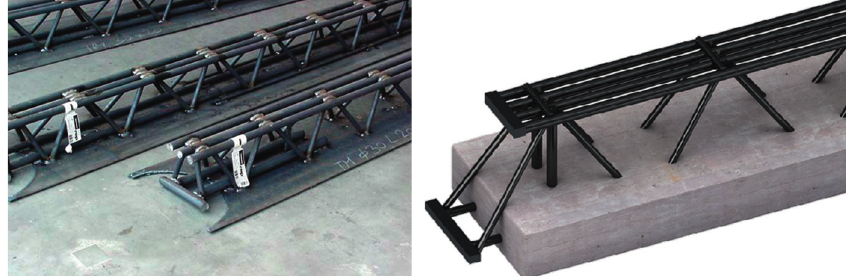
Figure 1: The two most common typologies of CTSC beams with steel and concrete